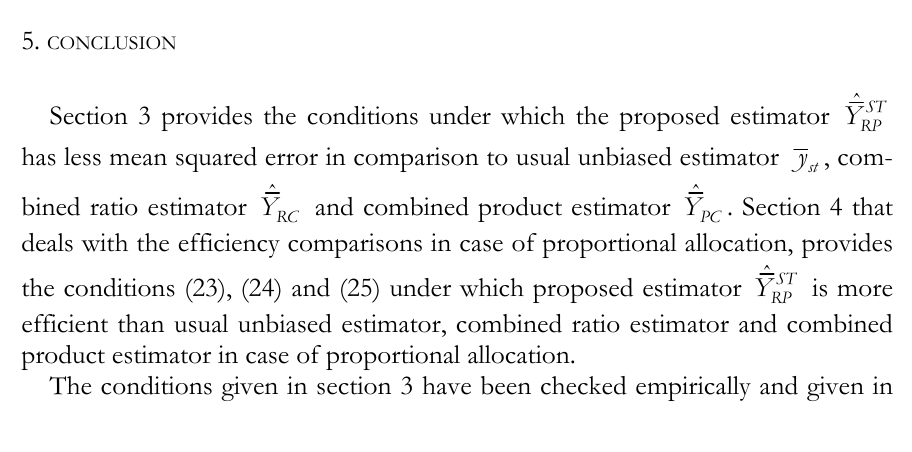
ˆ ST Y with respect to RP